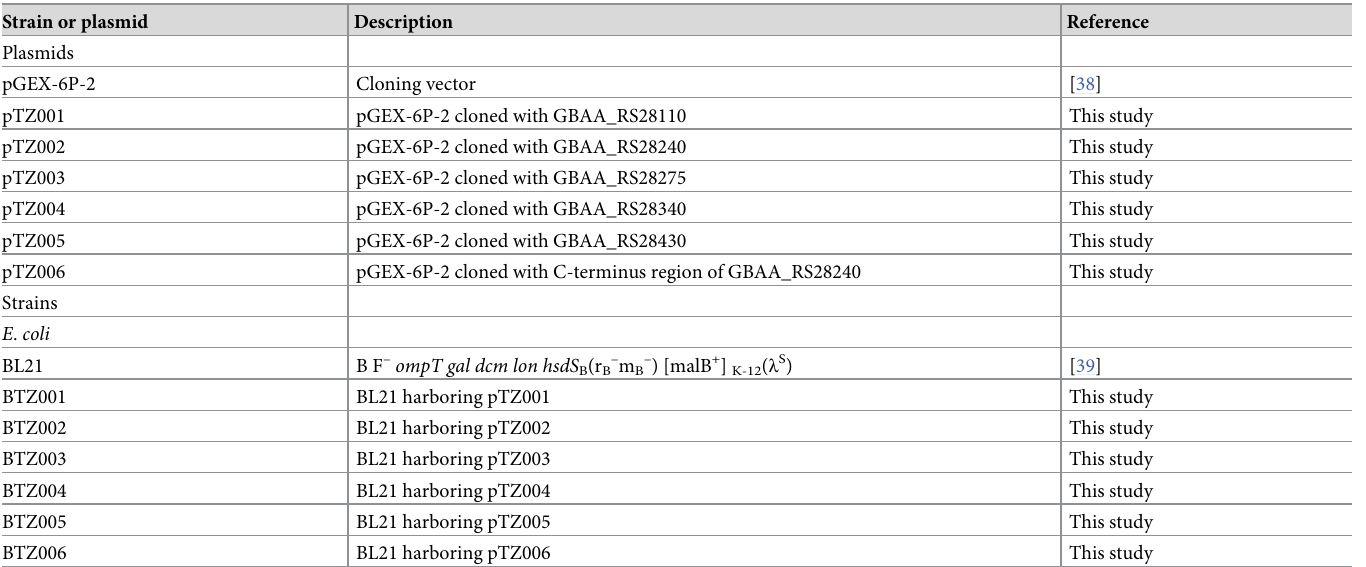
Table 3. Constructs and strain